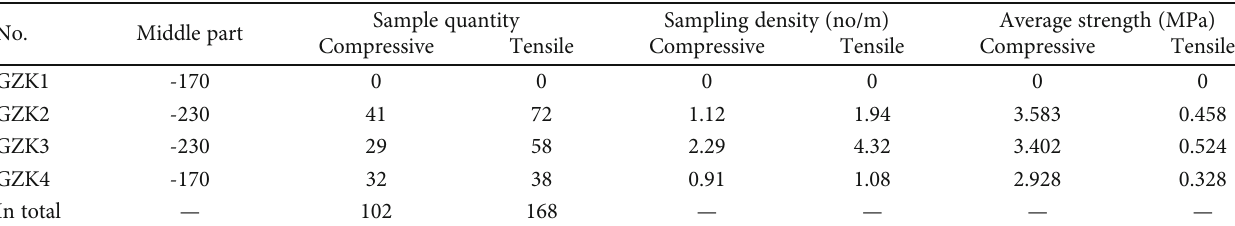
Figure 10: Uniaxial tensile strength test. Table 3: Strength test data of back fi